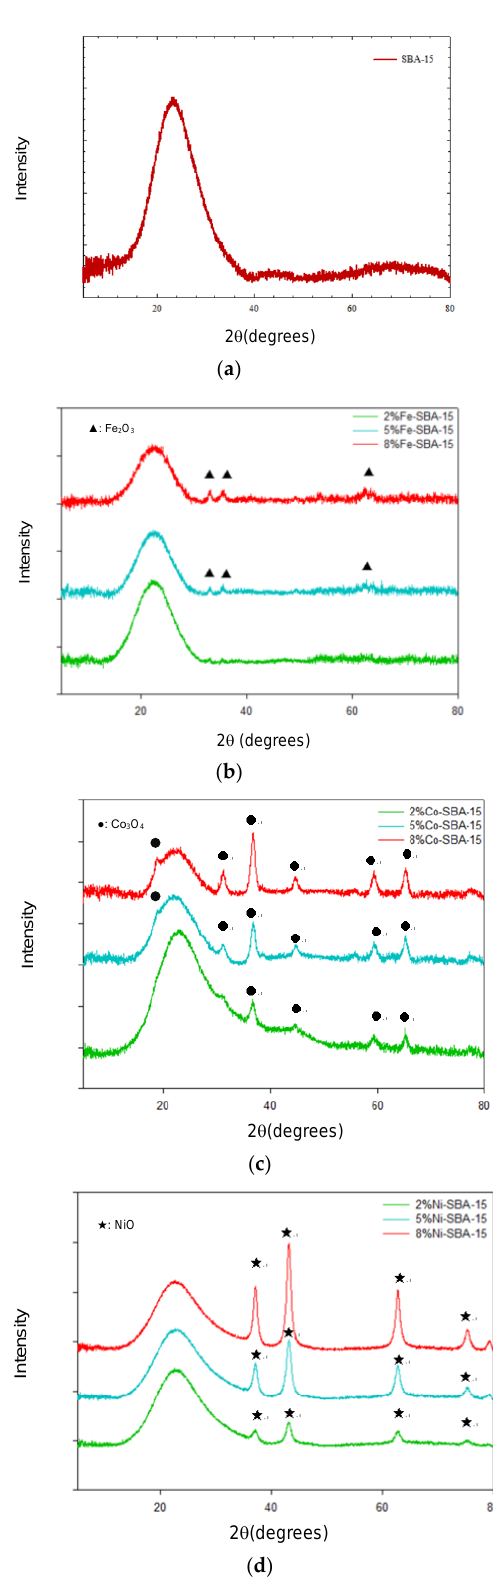
Figure 5. ( a )SAXS analysis of SBA-15.( b )SAXS analysis of 2 – 8wt% of Fe-SBA-15.( c )SAXS analysis of 2 – 8wt% of Co-SBA-15. ( d )SAXS analysis of 2 – 8wt% of Ni-SBA-15. SBA-15 and metal oxide-impregnated SBA-15 exhibited a broad silica peak near 23.8 ◦ , SBA-15 and metal oxide-impregnated SBA-15 exhibited a broad silica peak near indicating the amorphous silica on the support (Figure 6). 23.8°, indicating the amorphous silica on the support (Figure 6).